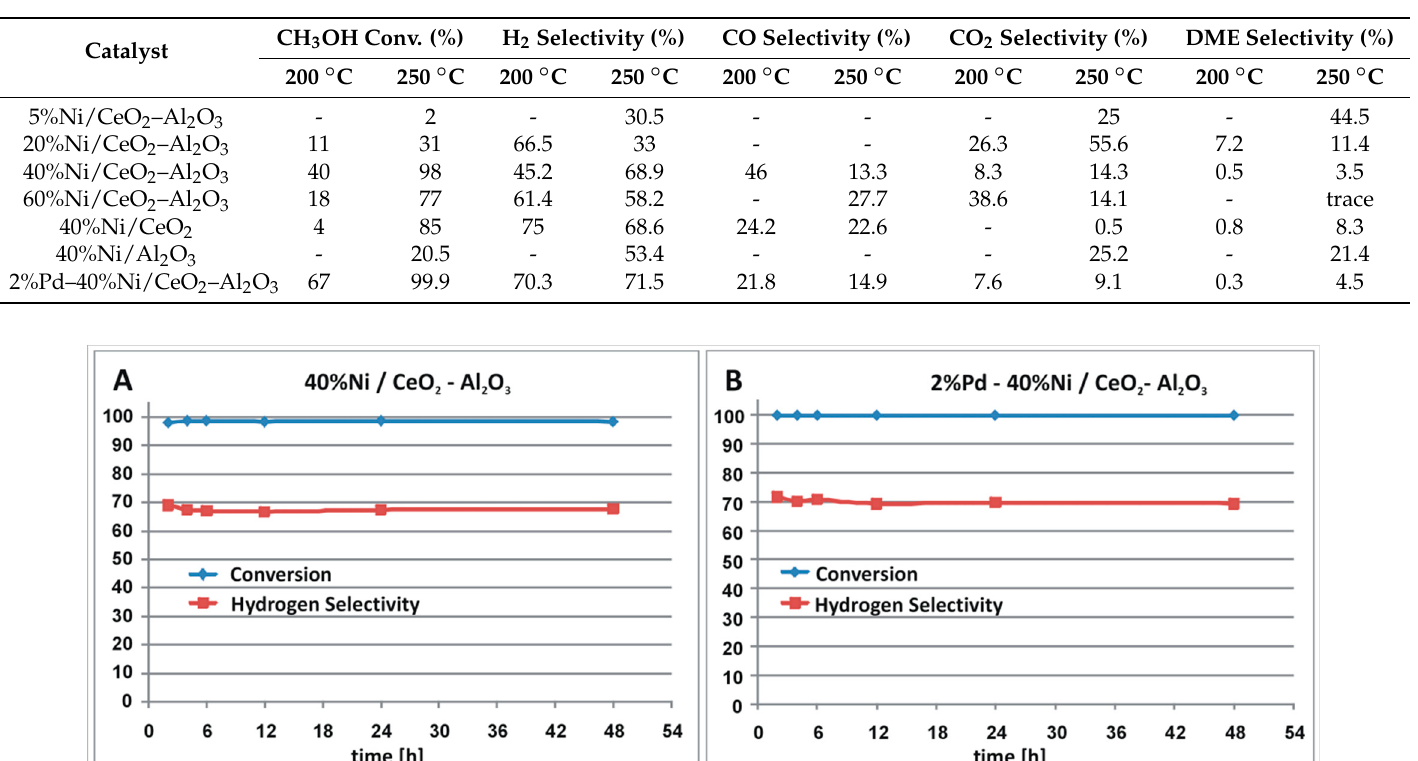
2 –Al 2 O 3 supported catalyst; and ( B ) bimetallic